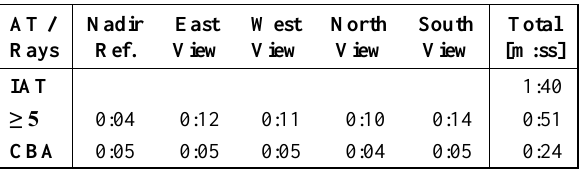
Table 7. Performance of integrated and hierarchical AT runs of the Heilbronn block, all values in